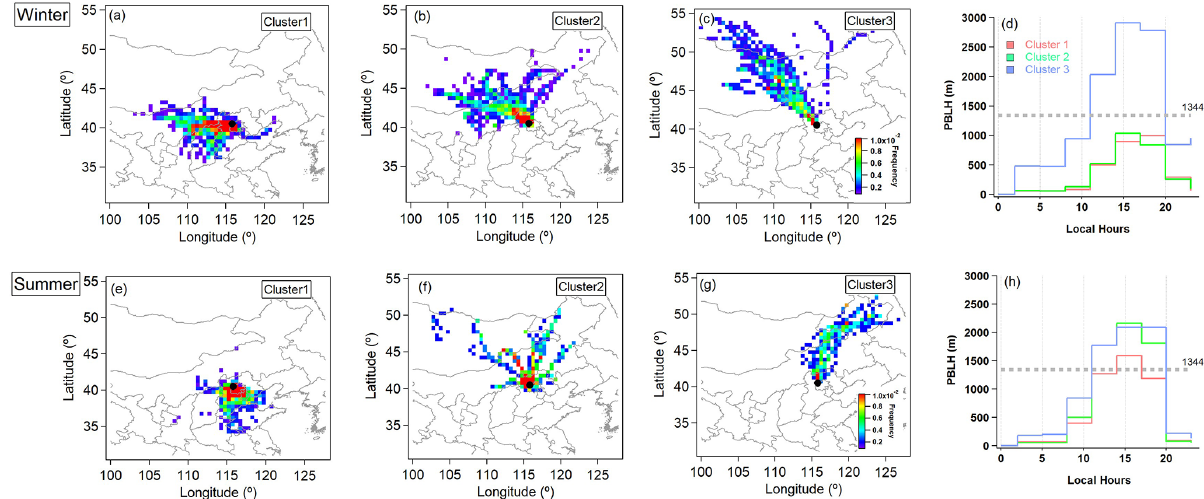
Figure 2. The clustered backward trajectories from the HYSPLIT model in both seasons: (a–c) for winter and (e–g) for summer, coloured by occurrence frequency in each geographic grid. Panels (d) and (h) are the diurnal variation of the height of the PBL for the three clusters in both seasons, with the dashed line denoting the mountain site